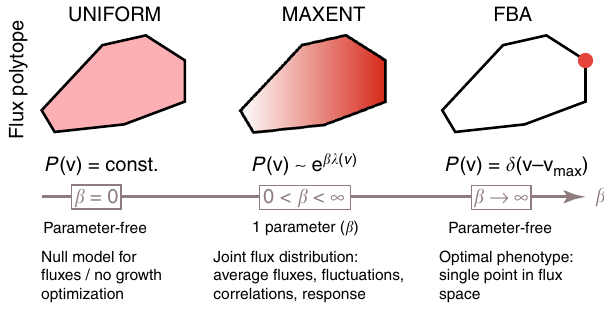
Fig. 1 Stoichiometric and thermodynamic constraints de fi ne a high- dimensional convex polytope of permissible fl uxes, here shown in cross- section schematically as a black polygon. In a uniform model, the fl ux distribution, P ( v ), is uniform over this polytope (UNIFORM). In contrast, fl ux balance analysis (FBA) fi nds a single permissible and optimal combination of fl uxes, v max (red dot), such that the growth rate is maximal, λ β → ∞ and β = 0, max . FBA and the uniform model are two limits (of respectively) of a one-parameter family of distributions (MAXENT), where increasing the parameter β biases the fl ux distribution (red gradient) away from uniform toward achieving higher average growth rates, (cid:1) λ ð β Þ . The distribution over fl uxes has a Boltzmann form from statistical physics and corresponds to a case where fl uxes are as random as possible